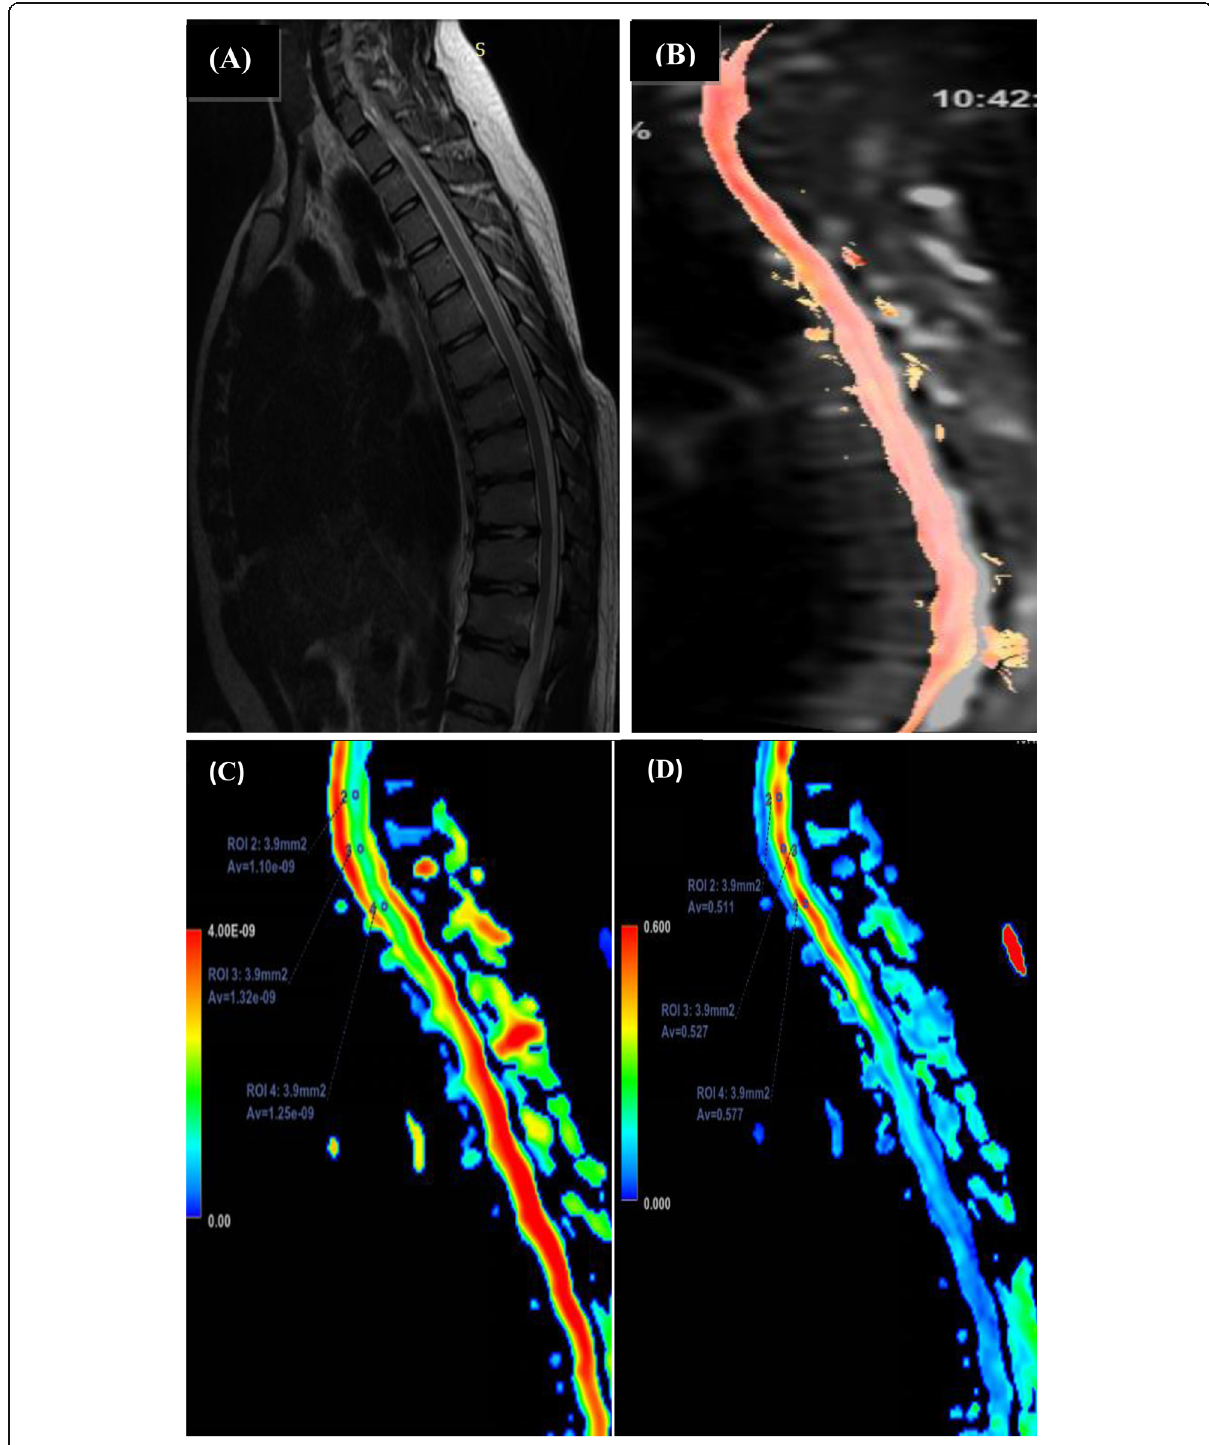
Fig. 1 a – d A 19 years old healthy male subject. a Sagittal T2-weighted MR image acquired at 1.5 T of a normal dorsal spine with normal osseous alignment, no abnormal marrow signal or abnormal cord signal. b Fiber tractography image shows intact white matter tract of dorsal spinal cord with no attenuation or interruption or displacement. c Sagittal color coded ADC map shows ADC values in different levels of the dorsal spine with no significant difference in between them (average 1.2). d Sagittal color coded FA map shows FA values in different levels of the dorsal spine with no significant difference in between them (average